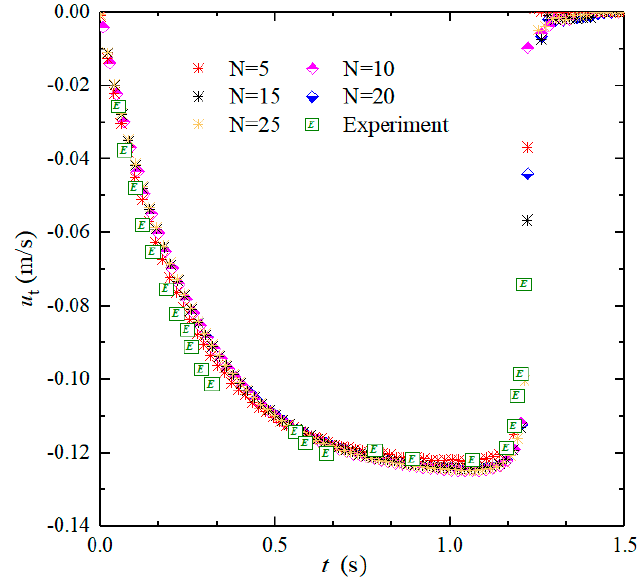
Figure 4. Evolution in the settling velocity from simulations with different resolutions (Re = 31.9).